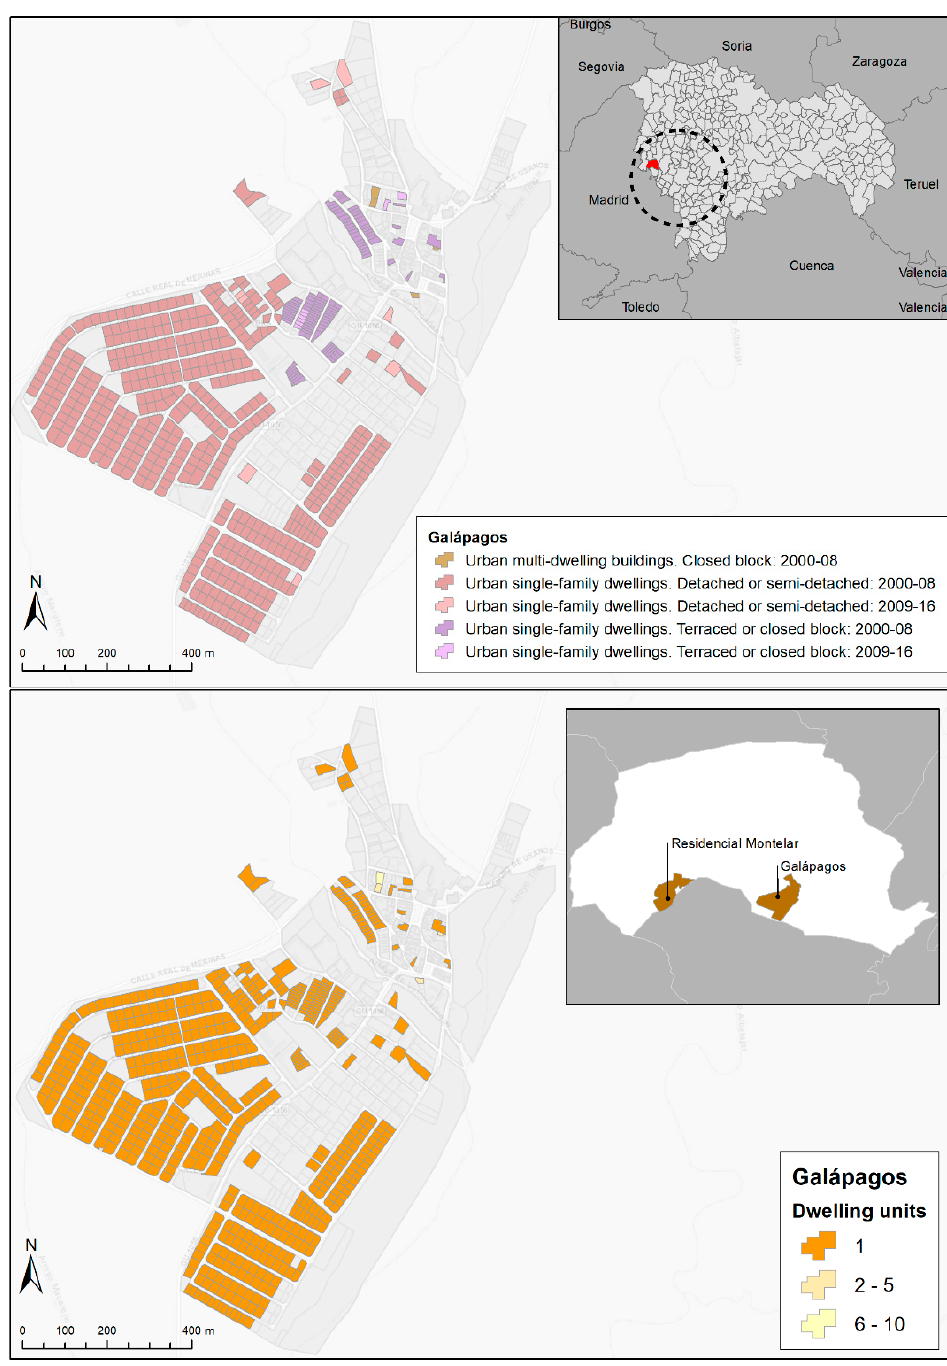
Figure 10. Number of dwellings and construction types (Galápagos). Own elaboration.